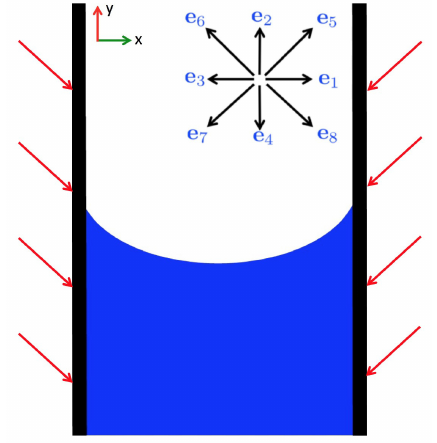
Figure 7. Illustration of side walls and wetting liquid: black lines are side walls, blue region represents liquid, above white region is vapor; the two side walls are heated for